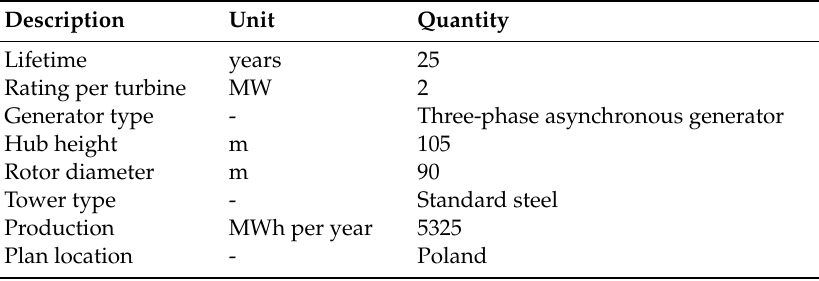
Table 1. Basic data of the Vestas V90 wind